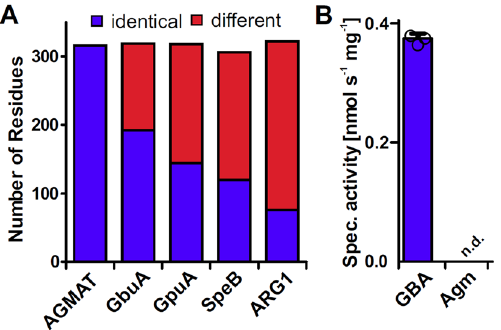
Figure 1. Sequence comparison and catalytic activity of human AGMAT variant R105. ( A ) Amino acid identity of the mature form of AGMAT compared to guandidinobutyrase (GbuA) and guanidinopropionase (GpuA) from Pseudomonas aeruginosa , agmatinase from Escherichia coli (SpeB) and human arginase 1 (ARG1). The numbers of identical (blue) and different (red) residues of the respective enzymes in comparison to AGMAT were derived from a multiple sequence alignment (Supplementary Fig. S1). ( B ) Specific activity of recombinantly expressed and purified AGMAT in the presence of 10 mM GBA or agmatine (Agm). Column represents the average of technical triplicates and consistent results were obtained with independent preparations (Data from Fig. 2C). (n.d. = not detected; limit of detection ~ 0.02 nmol s -1 mg -1 ), error bars,